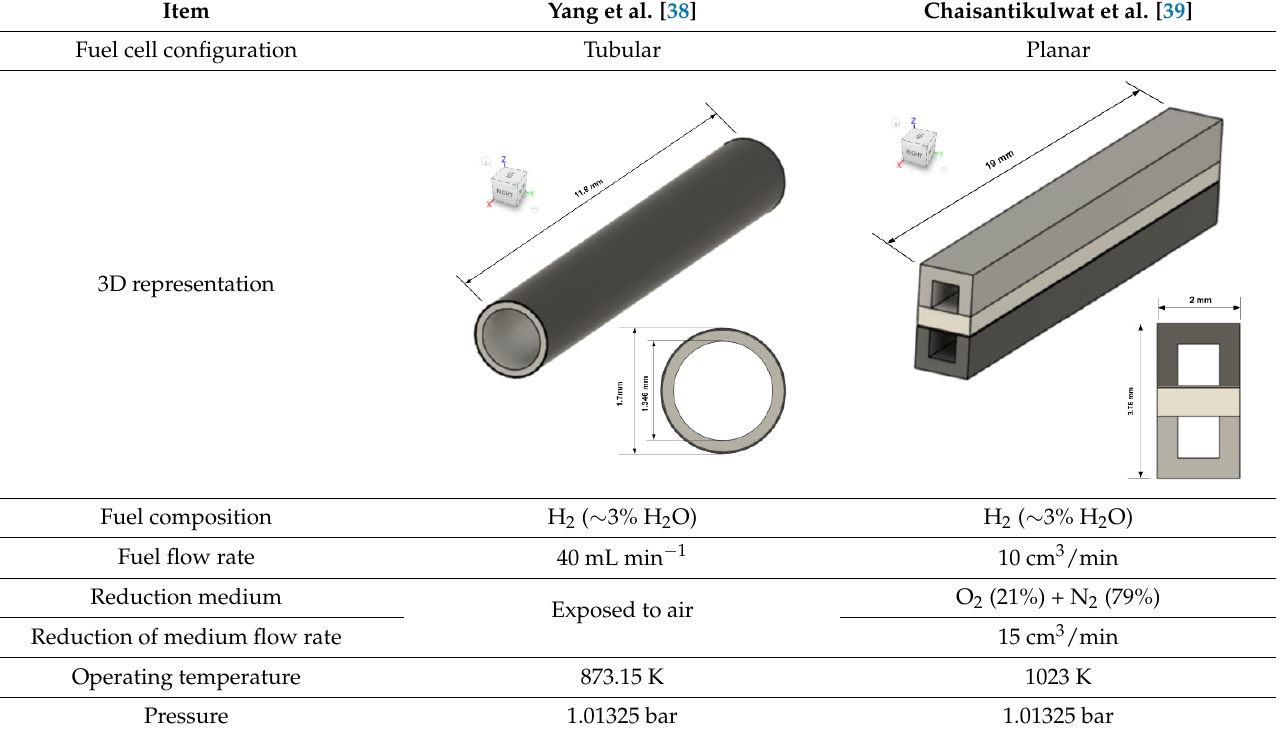
Table 5. The operating conditions for the various experimental studies used for model validation.